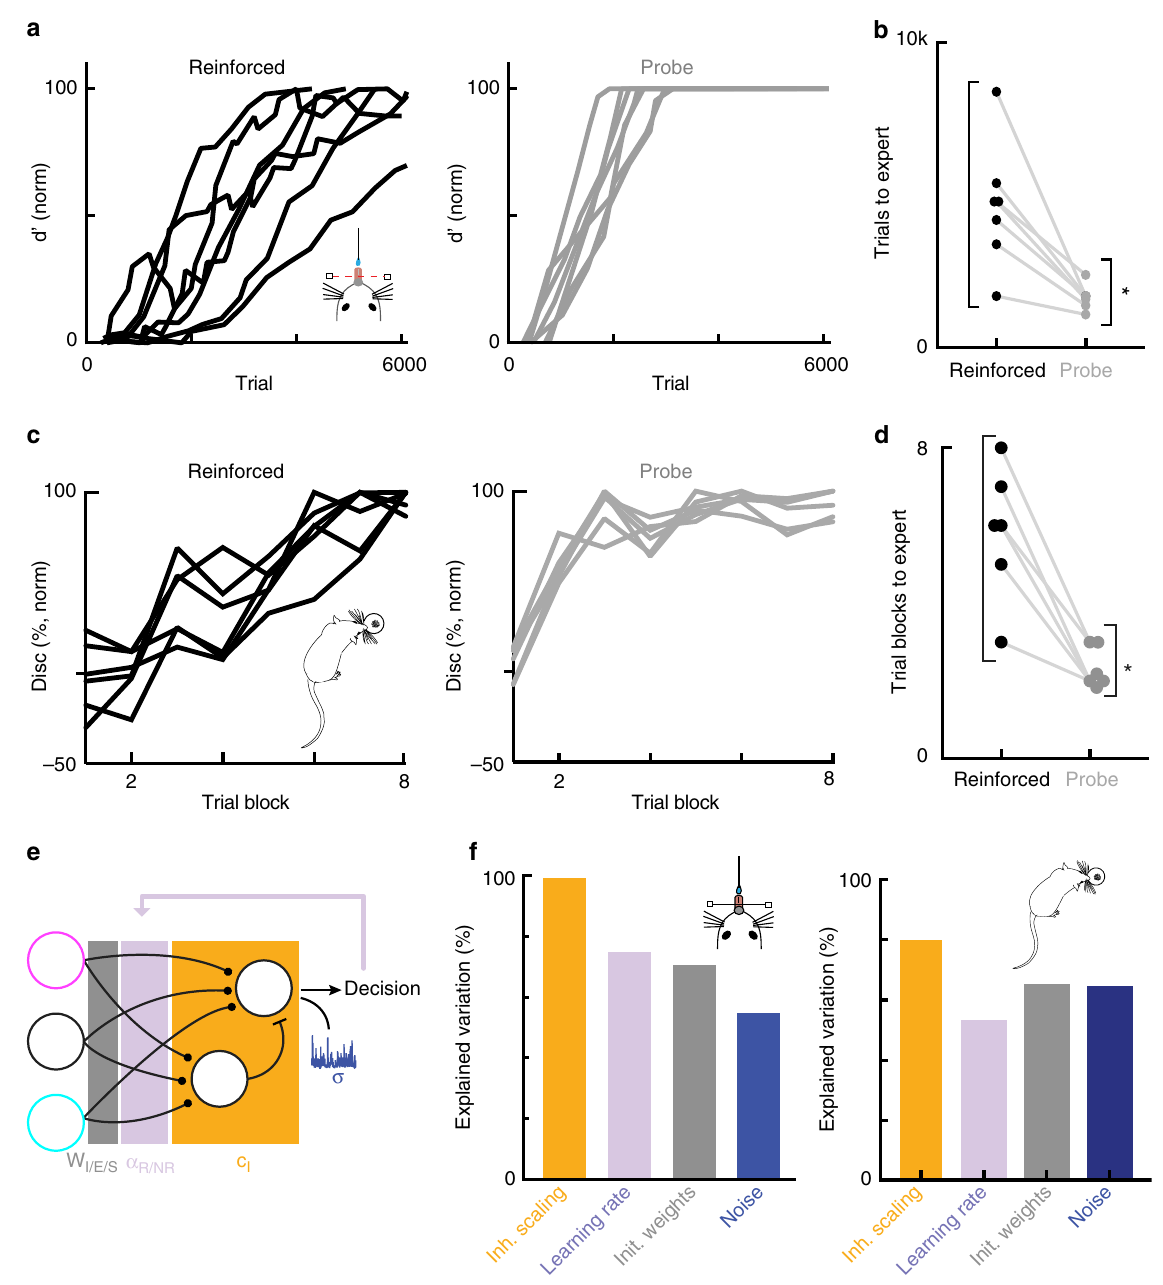
Fig. 4 Performance variance across rodents arises from contextual factors. a Left: normalized discrimination of all mice in the auditory go/no-go task over the over the course of learning ( N = 7 mice) in the reinforced context; right: same as left but in the probe context ( N = 7 mice). b Number of trials required for individual animals to reach expert performance levels ( d ’ > 2.0, false-alarm rate <50% for at least 100 trials) in the reinforced (black) and probe (gray) contexts. The number of trials required for expert performance is signi fi cantly more stereotyped across animals in the probe context than in the reinforced context (probe: st.d. = 358 trials, range = 1348 – 2332, n = 7 animals; reinforced: st.d. = 2047 trials, range = 2187 – 8838 trials, N = 7 mice, F(6,6) = 32.63, p = 5.025 × 10 − 4 , two-tailed two-sample F-test for equal variances). c Left: normalized discrimination of rats in the Pavlovian